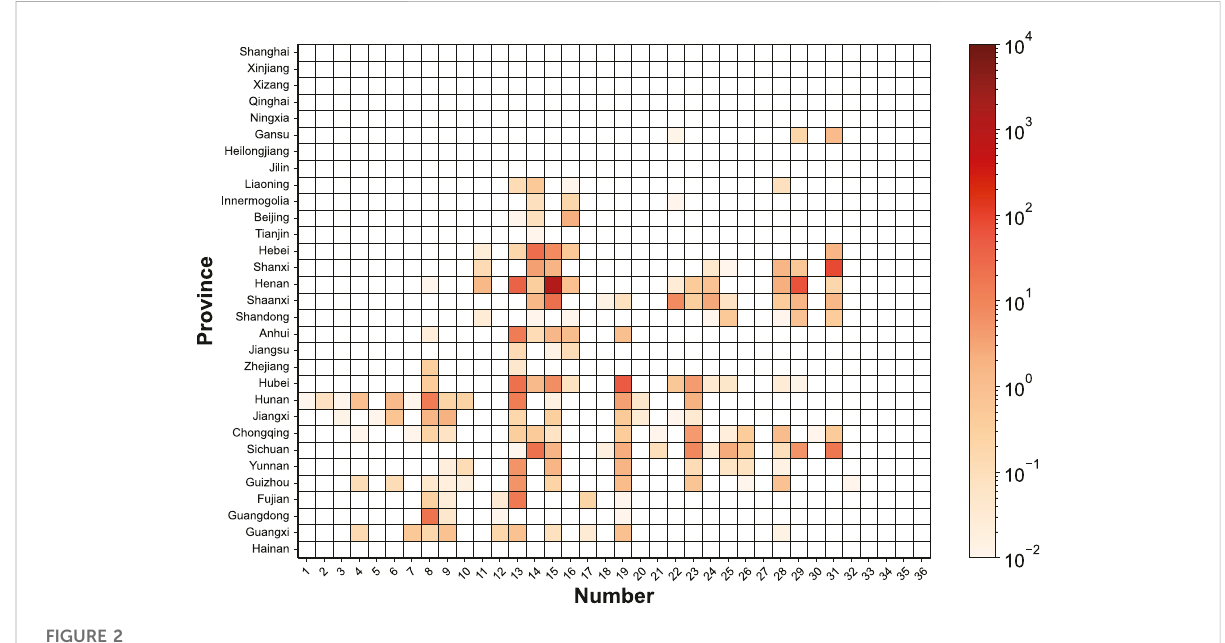
Distribution of provincial DELs for major rainstorm events in 2021 (Unit: 100 million